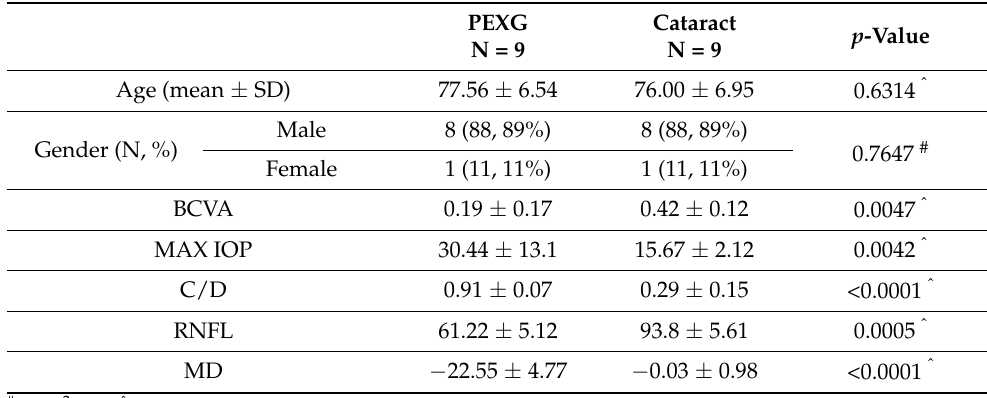
Table 1. Demographic and clinical characteristics of the study